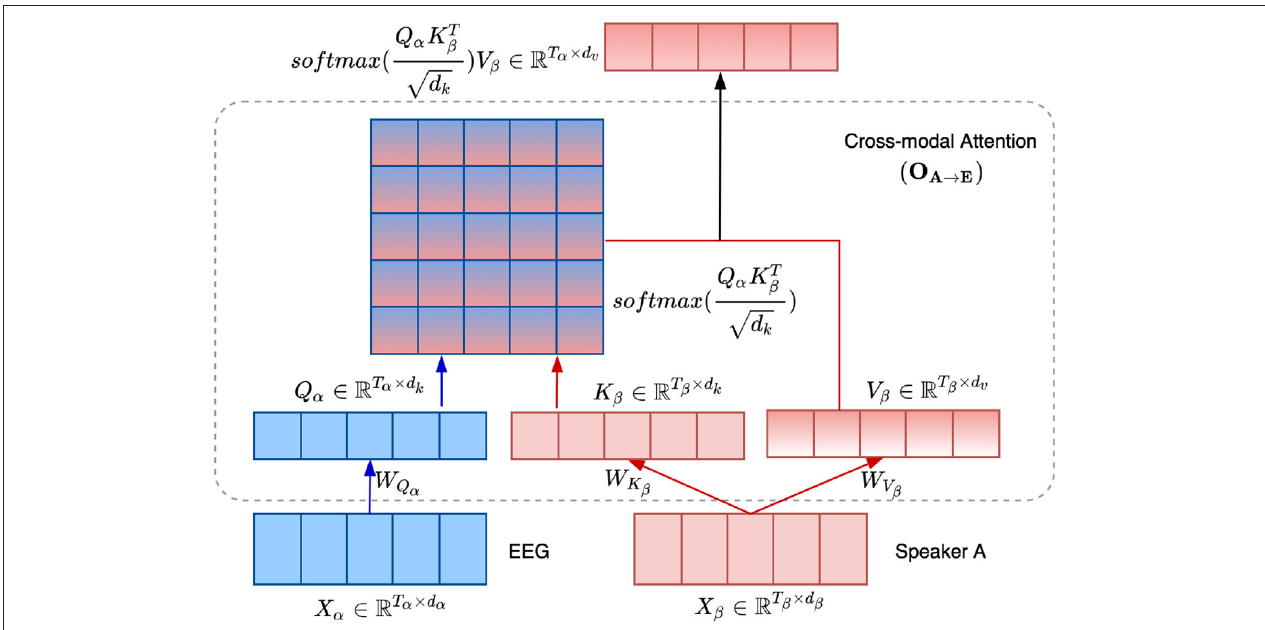
FIGURE 2 | Illustration of the cross-modal attention mechanism between the audio of speaker A and EEG signals, i.e., O A → E .